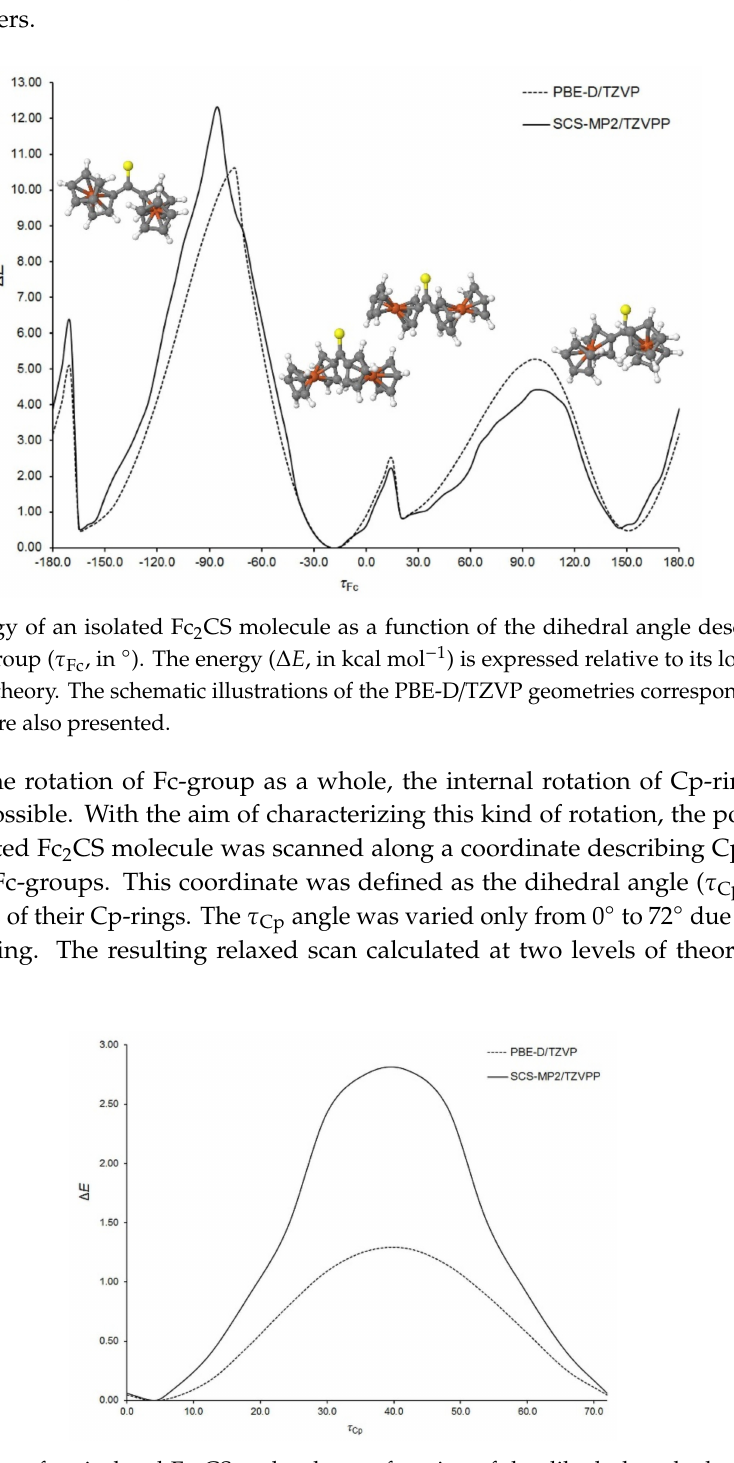
Figure 3. Energy of an isolated Fc 2 CS molecule as a function of the dihedral angle describing the rotation of Cp-rings within one of the Fc-groups ( τ Cp , in ◦ ). The energy ( ∆ E , in kcal mol − 1 ) is expressed relative to its lowest value at each level of